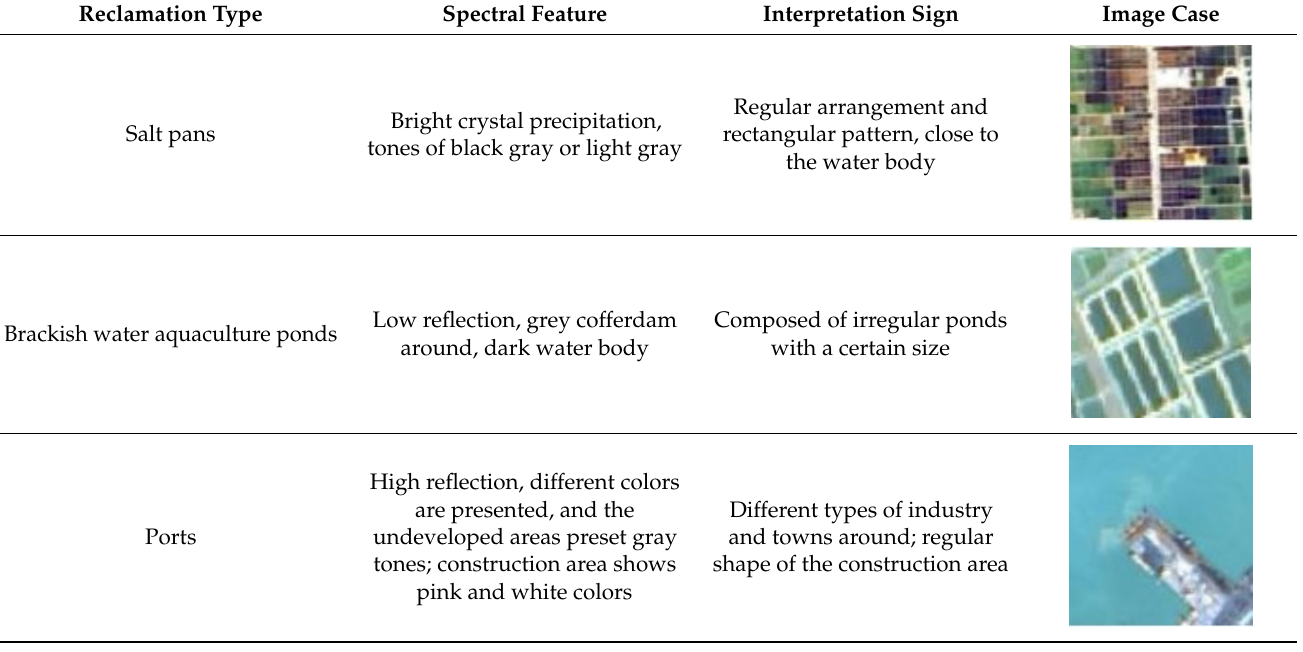
Table 2. Detailed information of interpretation keys for the reclamation classification.